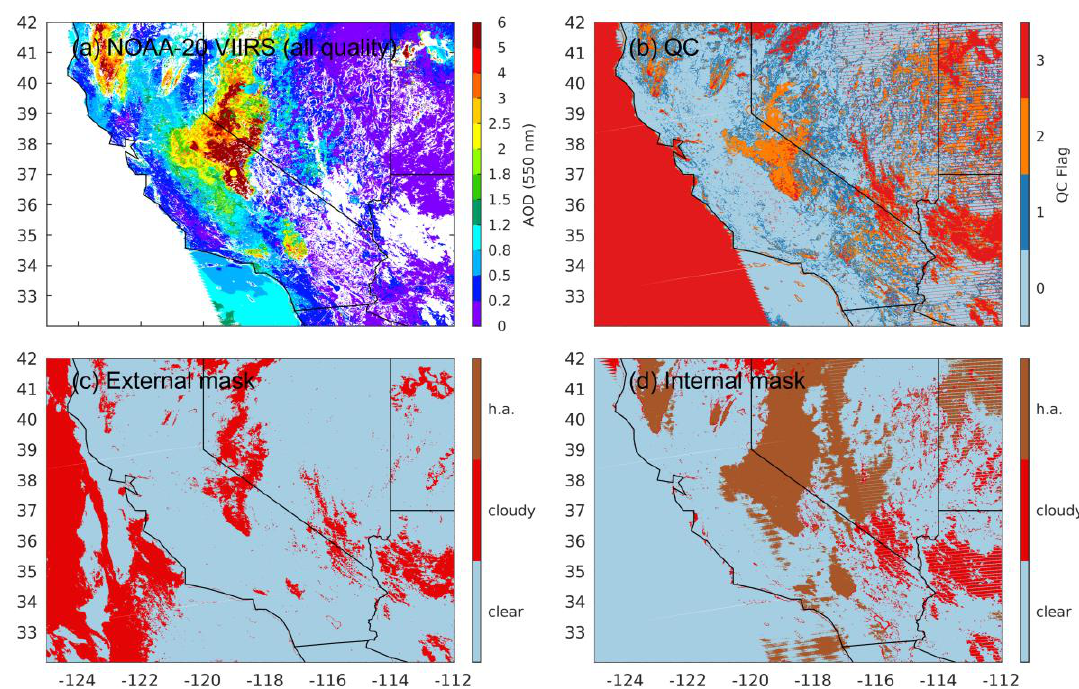
Figure 7. Maps of NOAA-20 VIIRS data on 14 September 2020. ( a ) AOD retrievals in all quality category (QCAll = 0, 1, 2); ( b ) Retrieval quality flag (QCAll, 0: high, 1: medium, 2: low, 3: no retrieval); ( c ) External mask and ( d ) internal mask for clear, cloudy, and heavy aerosol (h.a.) condi- tions.